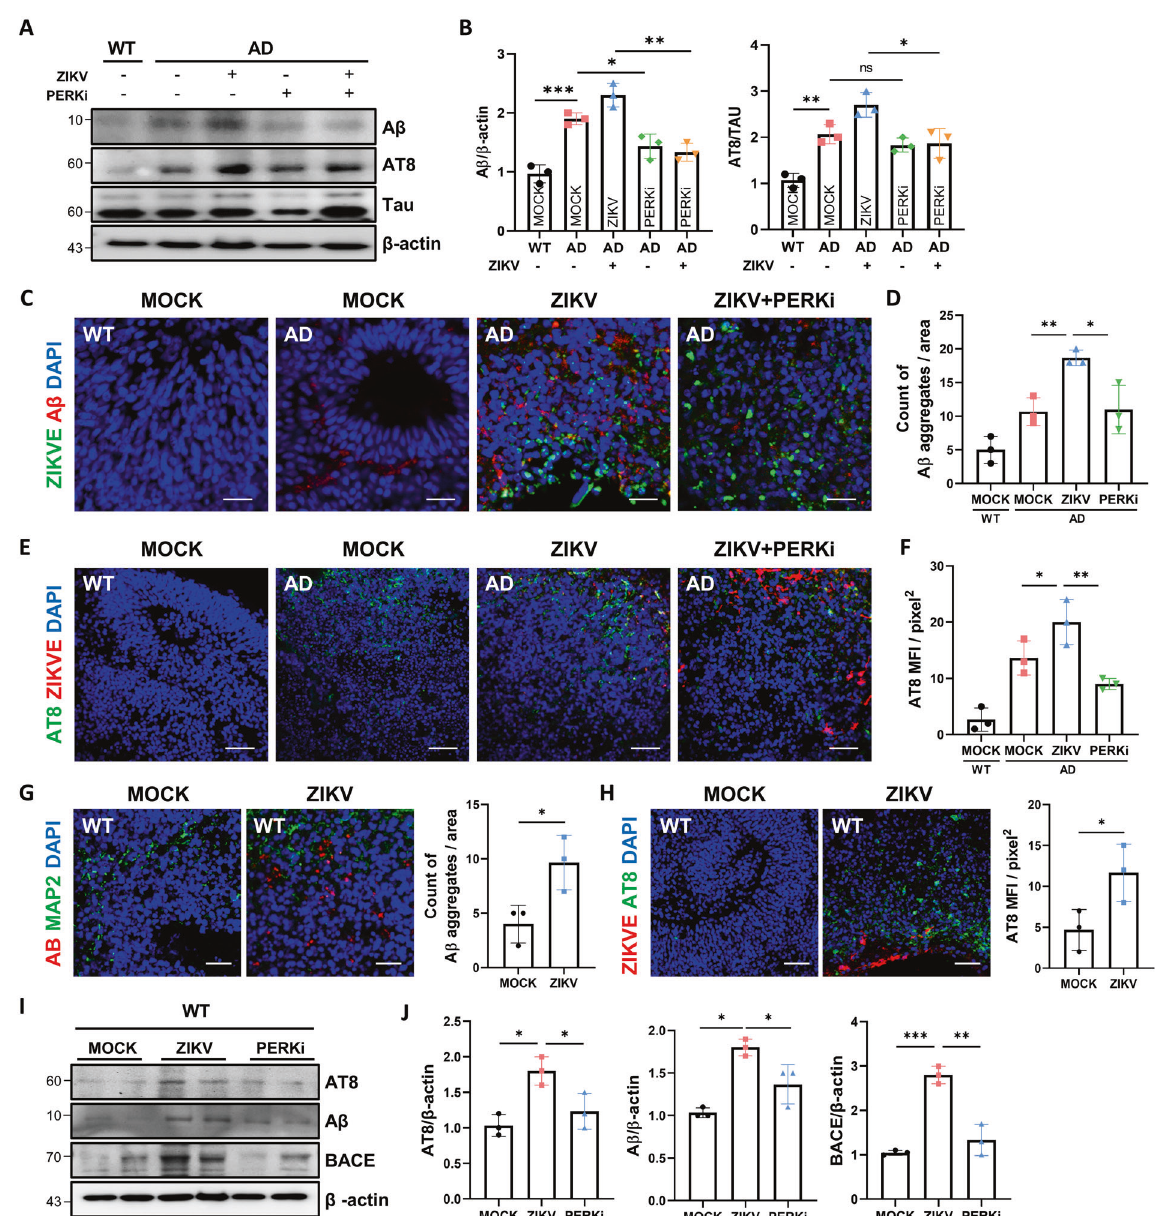
Fig. 6 PERK inhibitor attenuated AD phenotypes including A β and p-Tau. A PERK inhibitor (GSK2656157) was administrated for two weeks after ZIKV infection. Representative western blotting results showing A β , p-Tau, Tau, and β -actin. B The quanti fi cation of A β and p-Tau. A β was normalized to β -actin and p-Tau was normalized to Tau protein ( n = 3). C Representative immuno fl uorescence image showing A β aggregation in each organoid. Scale bars, 50 µm. D The level of A β was analyzed in each organoid 14 dpi. The bar graph shows the quanti fi cation of A β aggregates per area in WT and AD organoids exposed to mock conditions, ZIKV and PERKi treatment after ZIKV infection ( n = 3). E Representative immuno fl uorescence image showing p-Tau with AT8 (Ser202/Thr205) in each organoid. Scale bars, 50 µm. F The level of p-Tau was analyzed in each organoid 14 dpi. The bar graph shows the quanti fi cation of p-Tau immunoreactivity in AD organoids exposed to mock conditions, ZIKV, and PERKi treatment after ZIKV infection ( n = 3). G Representative immuno fl uorescence images showing A β and MAP2 in WT organoids exposed to mock conditions and ZIKV ( n = 3). Scale bars, 50 µm. H Representative immuno fl uorescence images showing p-Tau and ZIKVE in WT organoids exposed to mock conditions and ZIKV ( n = 3). Scale bars, 50 µm. I Western blotting showing A β , BACE, p-Tau, and β -actin in WT organoids. J Quanti fi cation of A β and p-Tau was normalized to β -actin ( n = 3). n.s.: not signi fi cant, * P < 0.05, and ** P < 0.01. The data are presented as the mean ± SD. Infection of the brain organoids (Gibco), 1X B27 supplement without vitamin A (Gibco), 2-mercaptoethanol, On day 60, the brain organoids were infected with ZIKV diluted in CODM at 1X insulin (Sigma), 1X GlutaMAX (Gibco) and 1X MEM-NEAA (Gibco). After 0.2 MOI and 2 MOI. The cells were subjected to ZIKV exposure for 24 h, and four days of stationary growth, the medium was changed, and the then, the medium was replaced with virus-free CODM and incubated at organoids in CODM with 1X N2 supplement (Gibco), 1X B27 supplement with vitamin A (Gibco), 2-mercaptoethanol, 1X insulin (Sigma), 1X GlutaMAX (Gibco) and 1X MEM-NEAA (Gibco) were transferred to an orbital shaker. Cell Death Discovery (2022)